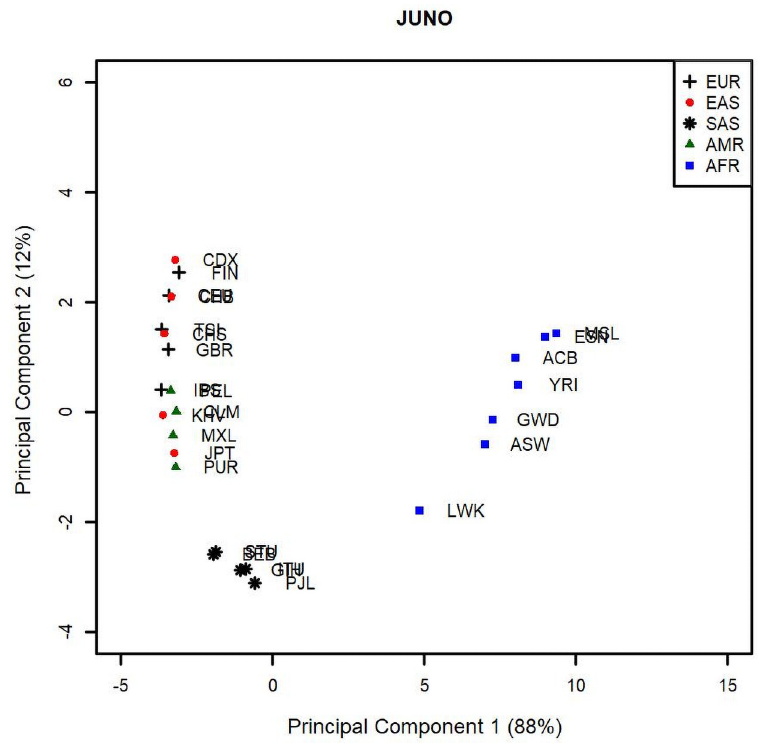
Fig 8. Principal component analysis of the F ST values for the JUNO gene between 26 population groups that form the supergroups AFR (square), EUR (cross), EAS (circle), AMR (triangle), and SAS (star). The percentages between parentheses correspond to the variance carried by each PC. AFR and SAS segregate from the other 3 population groups.